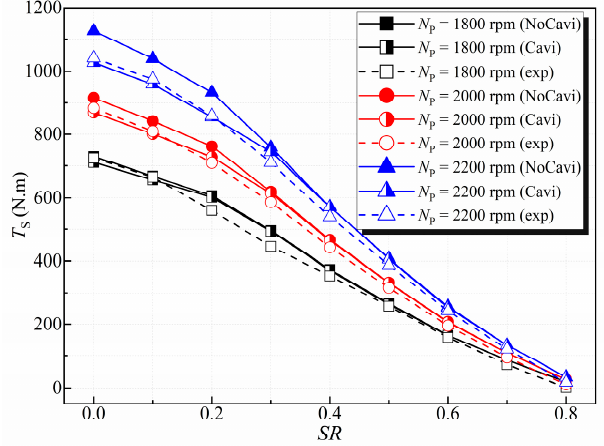
Figure 12. Comparison of the stator torque between simulation and test at stall under various N P.